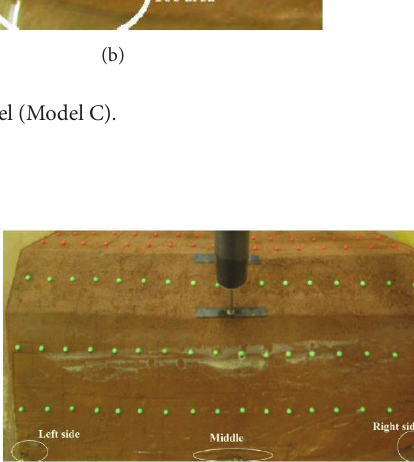
Figure 23: Damage in the fourth model (Model